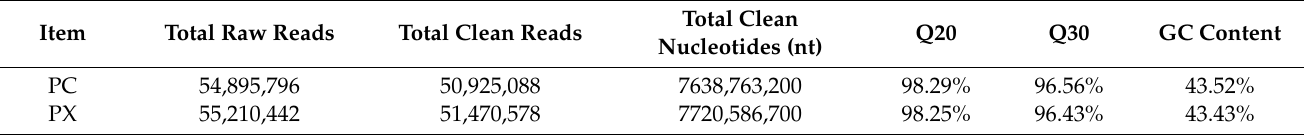
Table 1. Raw data output of Illumina RNA sequencing.